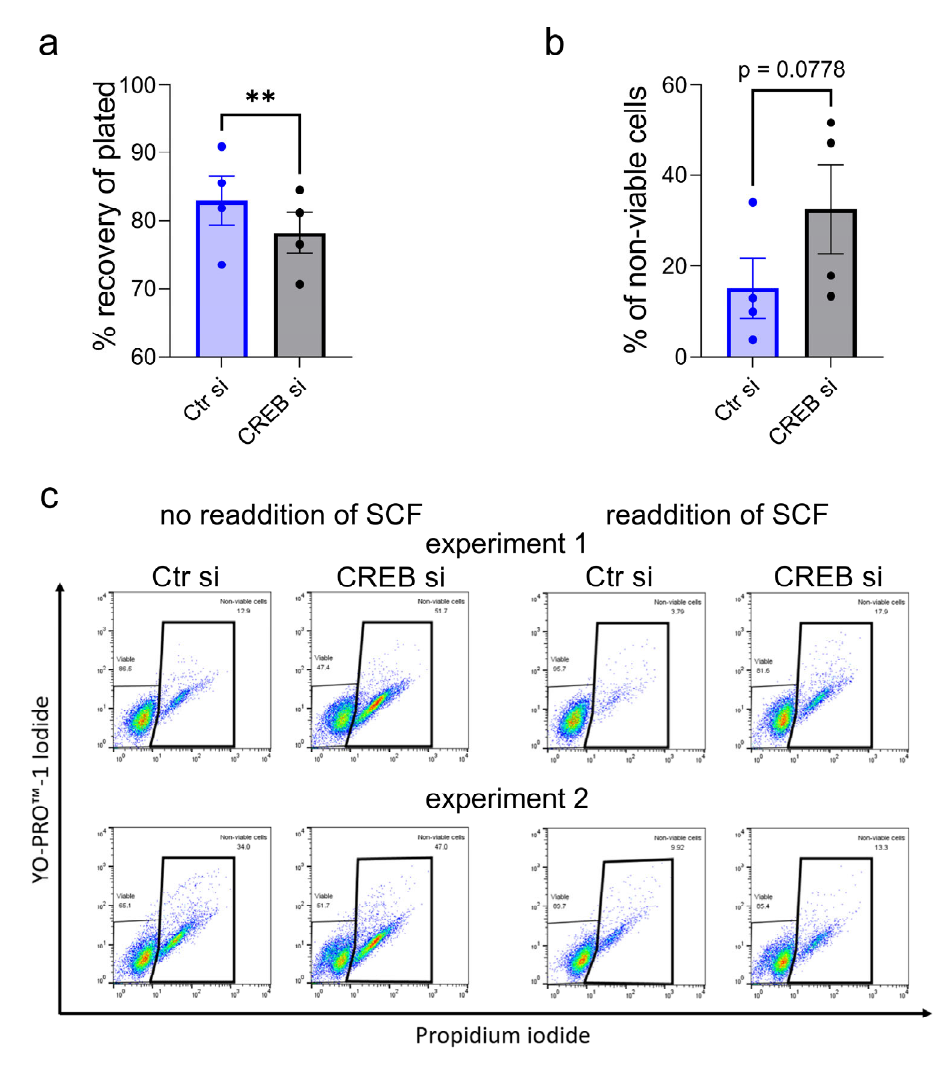
Figure 6. CREB is critically implicated in skMC survival—validation by RNA interference. ( a ) SkMCs were treated with control and selective siRNAs for 3 d. Cell numbers were determined and are expressed as % of the original numbers plated. ( b , c ) SkMCs were treated with control and selective siRNAs for 2 d (in the presence of SCF), then replated and kept for 2 more days with or without re-addition of fresh SCF. Viable versus non-viable/apoptotic cells were determined with the YoPro/PI technique. ( b ) Cumulative results of the two experiments run under two conditions each. ( c ) Dot plots of the two independent experiments. ** p <